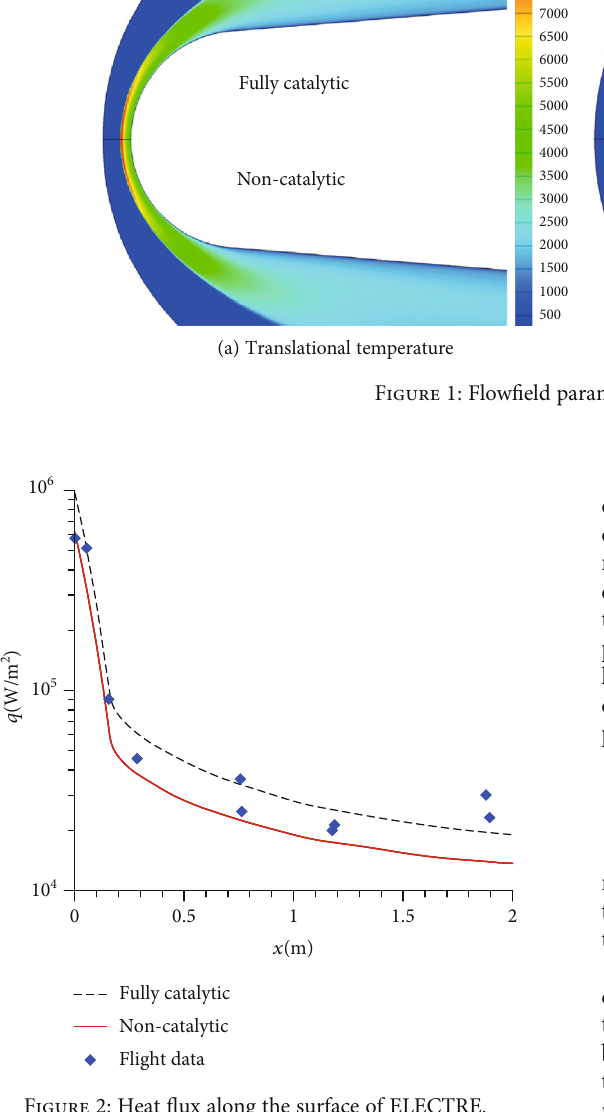
Figure 2: Heat fl ux along the surface of